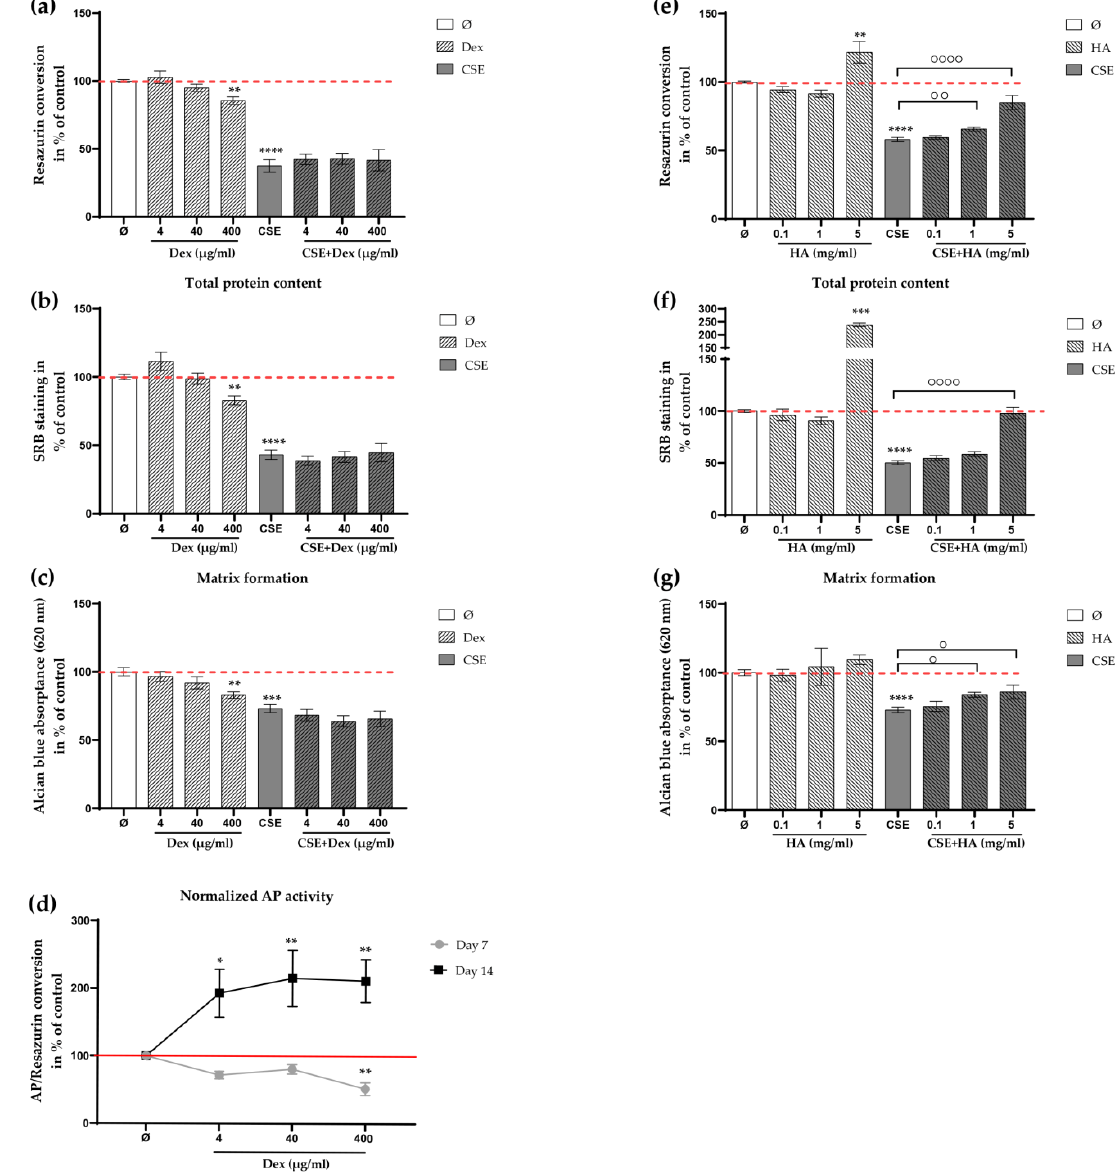
Figure 5. Effects of hyaluronic acid (HA) and decreased concentrations of dexamethasone (Dex) on CSE-impaired primary human chondrocytes. Cells ( N ≥ 3, n ≥ 3) were incubated with Dex (4, 40, and 400 μg/mL) or HA (0.1, 1, and 5 mg/mL) with or without 10% CSE. After 7 days of treatment, viability of the cells was measured by ( a , e ) mitochondrial activity (resazurin conversion) and ( b , f ) total protein content (SRB staining). ( c , g ) Matrix formation of cells was evaluated by quantifying Alcian blue staining. ( d ) AP activity of chondrocytes in the presence of different concentrations of Dex on day 7 and day 14. Results are given as fold change of control (untreated cells, represented in red line or red dotted line) and presented as mean ± SEM. * p < 0.05, ** p < 0.01, *** p < 0.001, **** p < 0.0001 vs. the control group, ° p < 0.05, °° p < 0.01, °°°° p < 0.0001compared to cells treated with CSE alone.